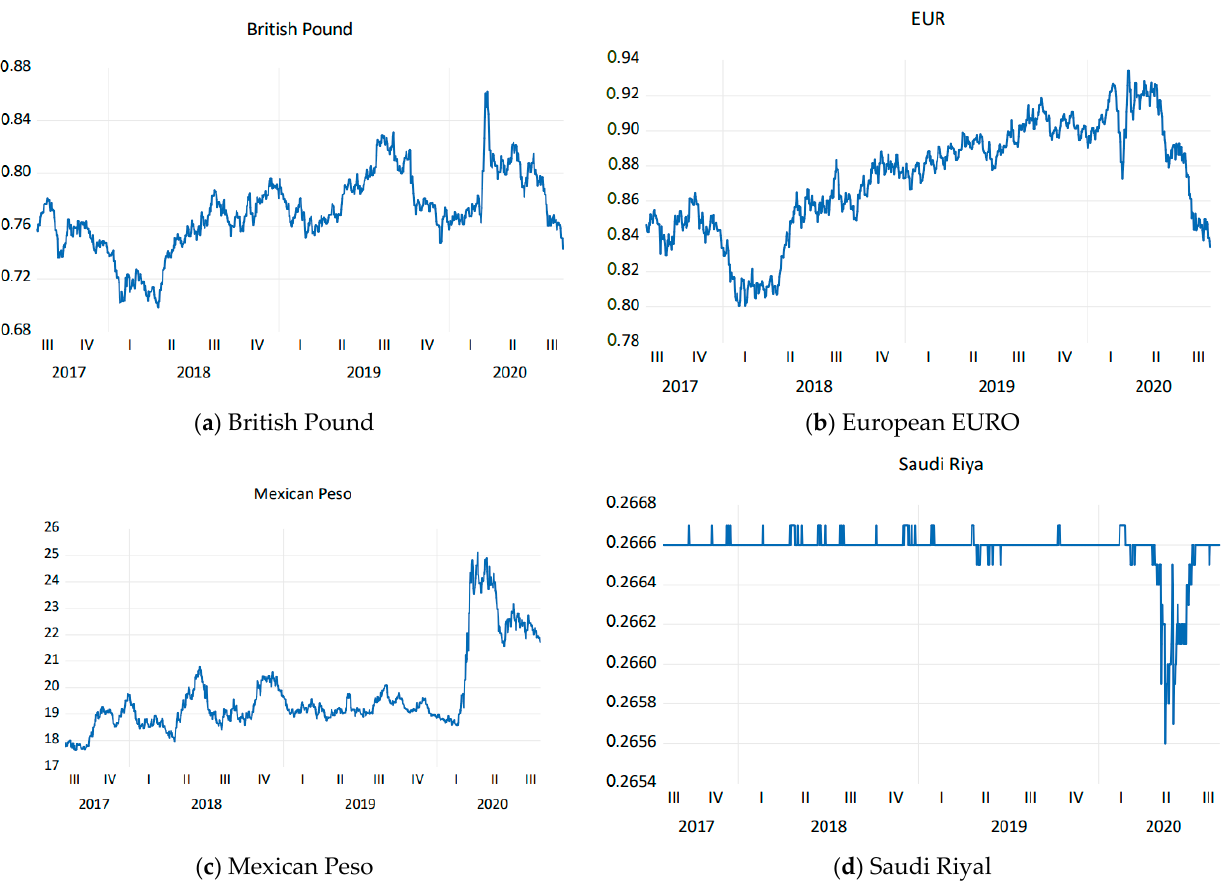
Figure 4. Daily time series of British pound, Euro, Mexican peso and Saudi riyal. Table 3. Descriptive Statistics for FOREX